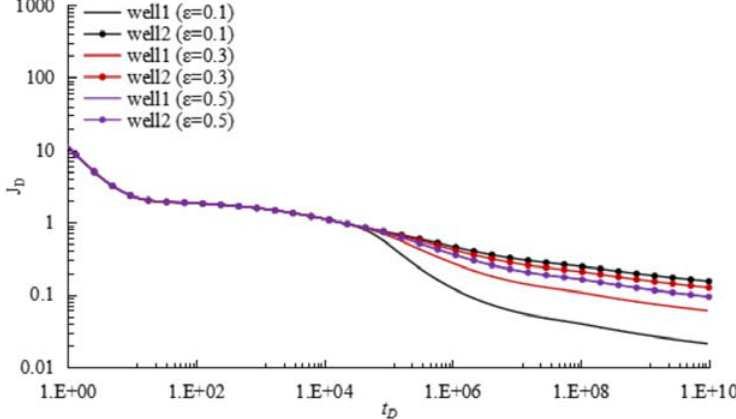
Figure 9. Effects of ratio of oil rate on MPI for WIPS scheme.